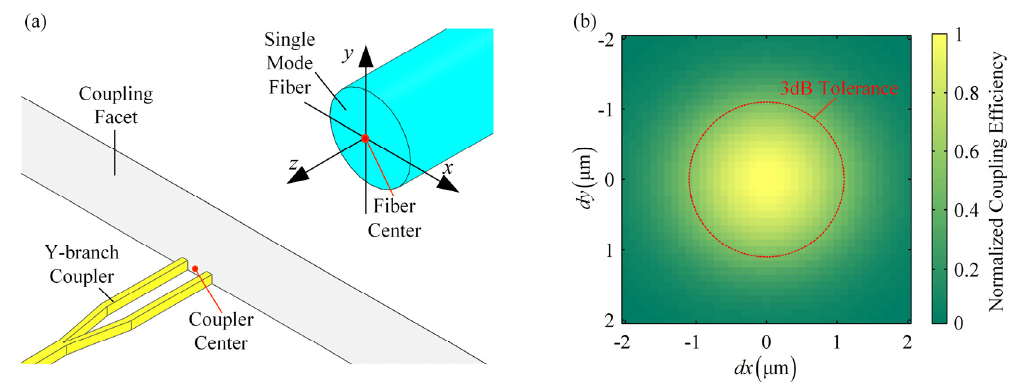
Figure 6. ( a ) Alignment of the single mode fiber (SMF) and waveguide RWS; ( b ) Influence of the deviation between the SMF center and waveguide center in the x − y plane on the coupling efficiency η y .